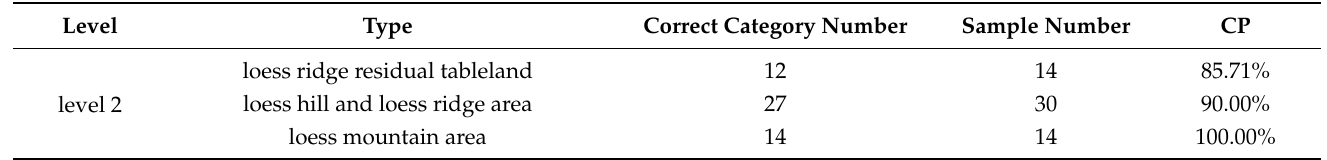
Table 4. Statistical results of the second level precision rate of hilly and gully and mountain areas.